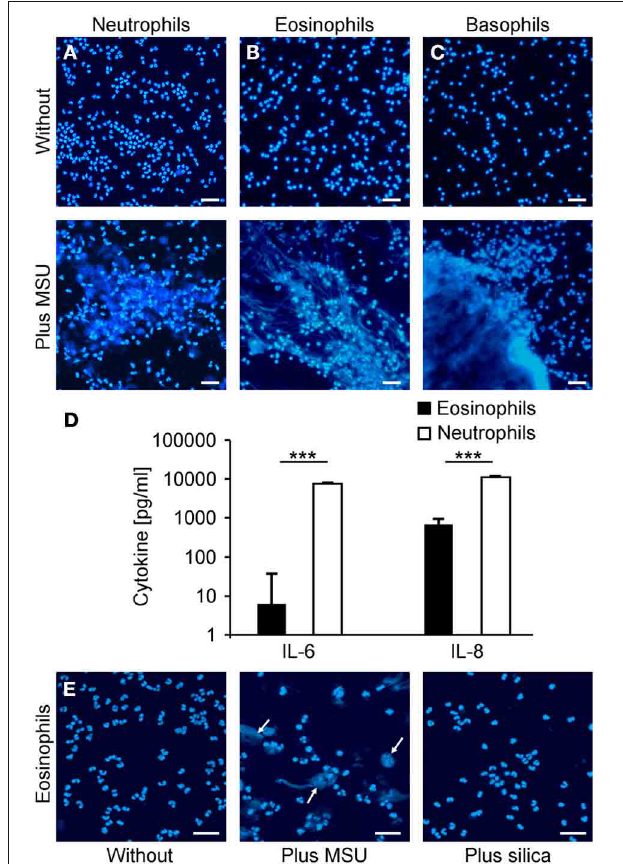
FIGURE 4 | Neutrophils, eosinophils and basophils form extracellular traps after incubation with MSU. (A–C) Isolated neutrophils (A) , eosinophils (B) or basophils (C) in plasma were incubated without (upper) or with MSU crystals (lower). Cytopsins were prepared and stained for extranuclear DNA. The DNA staining showed extracellular trap formation and clumping in neutrophils, eosinophils and basophils. (D) Cytokine/chemokine induction of eosinophils and neutrophils were analyzed after MSU incubation. Eosinophils produce traces of IL-6 and intermediate amounts of IL-8 after MSU incubation. Neutrophils release high amounts of IL-6 and IL-8 after incubation with MSU crystals. Values of mock-treated cells served as baseline. (E) Isolated eosinophils were incubated without (left), with MSU crystals (middle), or with silica crystals (right). The DNA staining shows extracellular trap formation (arrows) only in samples with MSU crystals. All experiments were performed at least three times. Scale bars, 100 μ m; ∗∗∗ P < 0 .